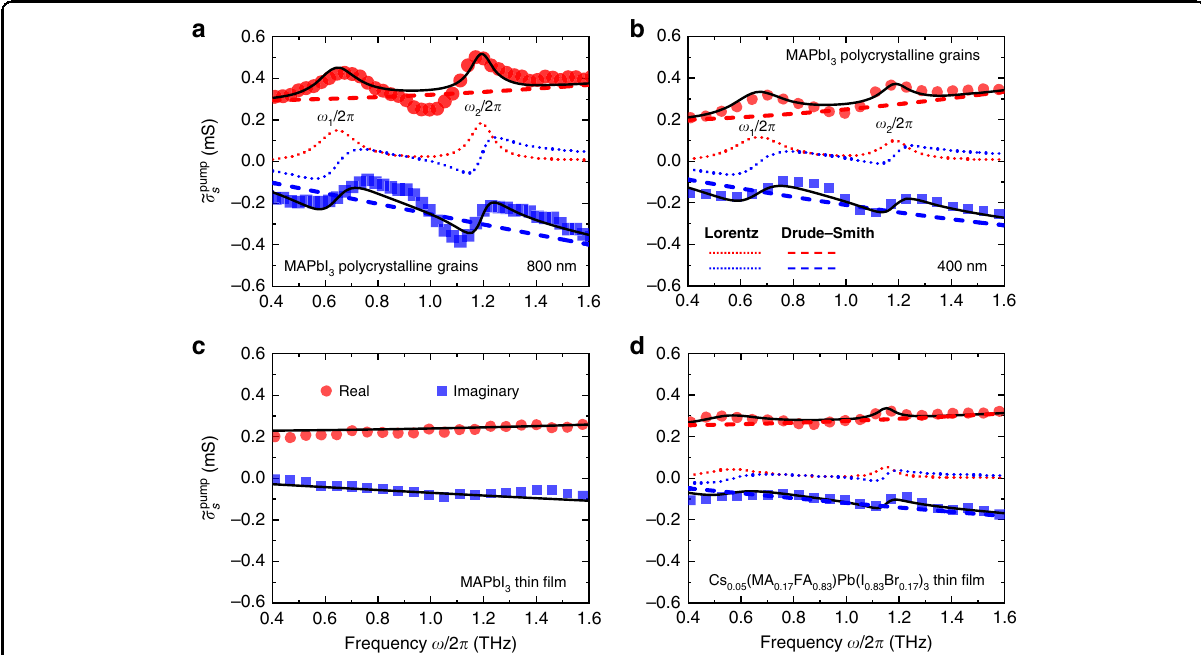
Fig. 2 The observation of photoinduced large polaron in MAPbI 3 . Real (circles) and imaginary (squares) parts of the sheet photoconductivity spectra of MAPbI 3 polycrystalline grains for two different pumped energies of a 1.55 eV and b 3.1 eV, at Δ t = 5 ps. The complex sheet photoconductivity spectra for c MAPbI 3 thin fi lm and d Cs 0.05 (MA 0.17 FA 0.83 )Pb(I 0.83 Br 0.17 ) 3 thin fi lm with pumped energy of 3.1 eV, at Δ t = 5 ps. The black curves in ( a ), ( b ), and ( d ) represent the Drude – Smith – Lorentz fi ts. The dashed and dotted lines show the components for the Drude – Smith term and the Lorentz terms,